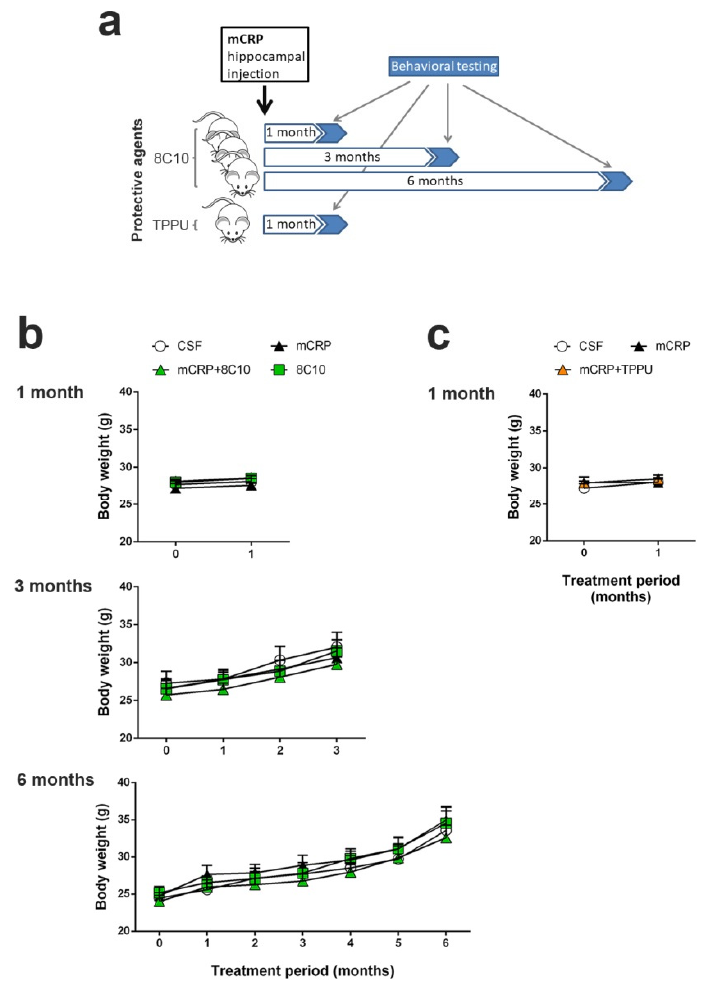
Figure 1. Monomeric C-reactive protein (mCRP) treatment in C57BL/6J male mice. ( a ) Scheme of the experimental design (see Methods Section for details). ( b ) Body weight control for the 1-, 3- and 6-month studies assaying a protective treatment with the anti-mCRP antibody 8C10 and ( c ) for the 1-month study assaying a protective treatment with Trifluoromethoxyphenyl-3-(1-propionylpiperidin-4-yl)-urea (TPPU). Progression of body weight confirmed the absence of unwanted systemic effects. Values are mean ± SEM (( b ) 1-month graph: CSF N = 6, mCRP N = 9, mCRP + 8C10 N = 12 and 8C10 N = 6; 3-month graph: CSF N = 13, mCRP N = 12, mCRP + 8C10 N = 12 and 8C10 N = 11; 6-month graph; CSF N = 11, mCRP N = 11, mCRP + 8C10 N = 12, 8C10 N = 10. ( c ) CSF N = 9, mCRP N = 9 and mCRP + TPP N = 9).